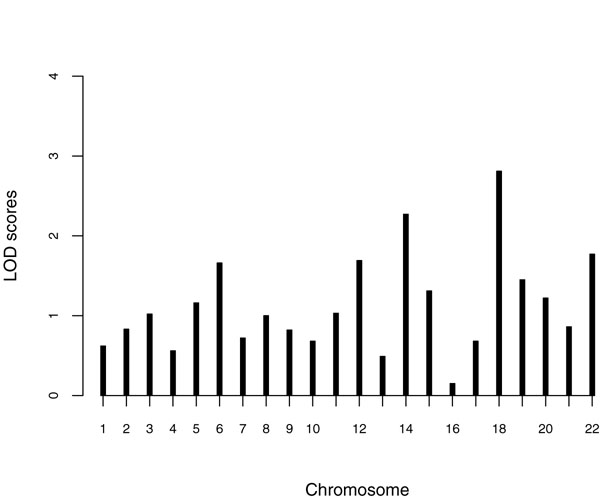
Highest imprinting LOD score per chromosome Chromosomes analyzed with sex-averaged maps.